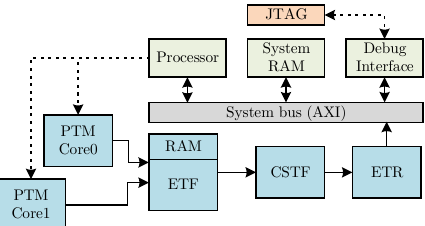
Figure 10: CoreSight configuration as used on the Huawei R216h 4G/LTE modem. Trace data from the two PTMs which monitor cores 0 and 1 of the ARM CPU is initially stored in the local memory of the Embedded Trace FIFO (ETF) module. From there trace data is fetched via the CoreSight Trace Funnel (CSTF) by the Embedded Trace Router (ETR) module and transferred to the system RAM. Finally, the trace data in RAM is accessed externally through the JTAG